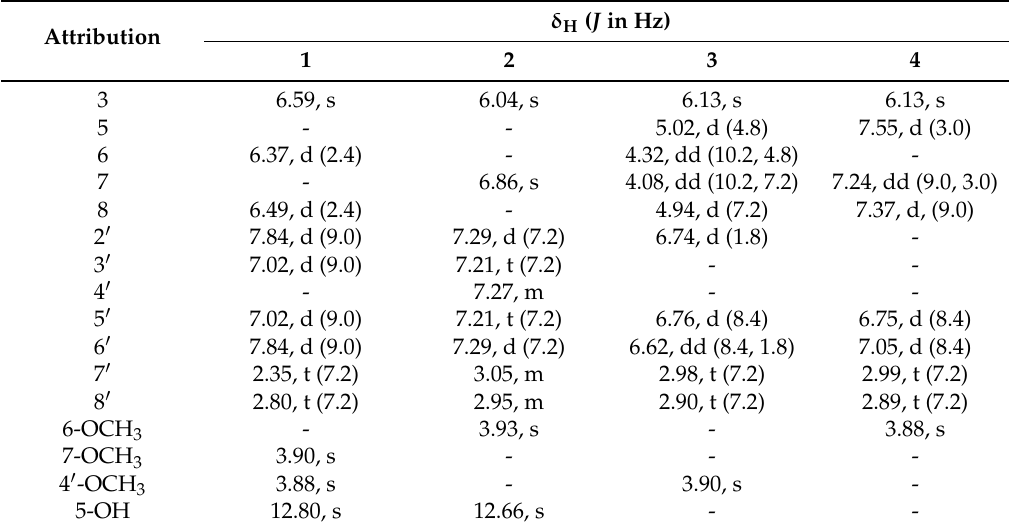
Table 2. 13 C-NMR (150 MHz) assignments of compounds 1 – 4 (CDCl 3 ).